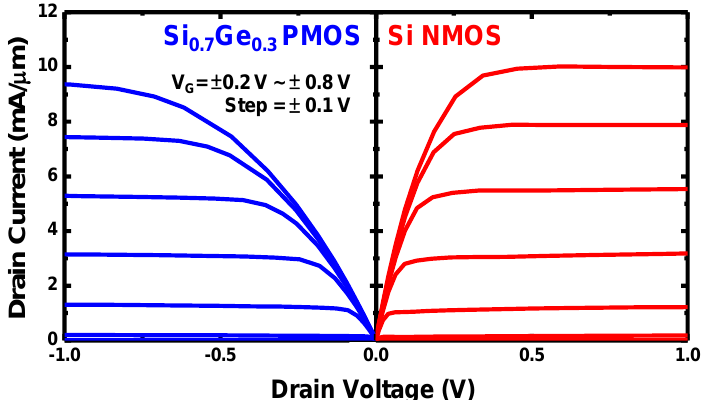
Figure 7. I D -V D output characteristic of Si 0.7 Ge 0.3 PMOS and Si NMOS in CFET structure with L G = 12 nm, showing good symmetric output current. Figure 8a,b show the analysis of the electrical characteristics including V TP and sub-